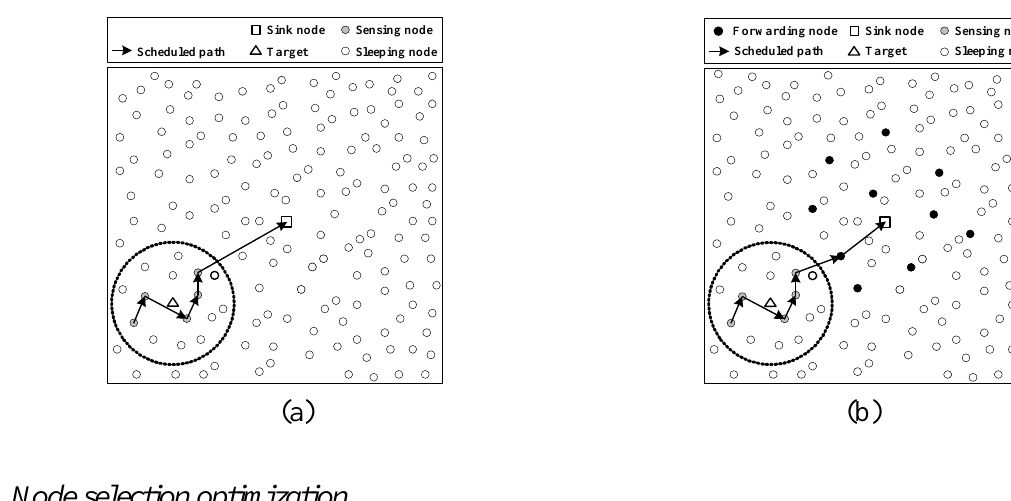
Figure 3. Routing schemes for target tracking application: (a) Without forwarding nodes; (b) With forwarding nodes.